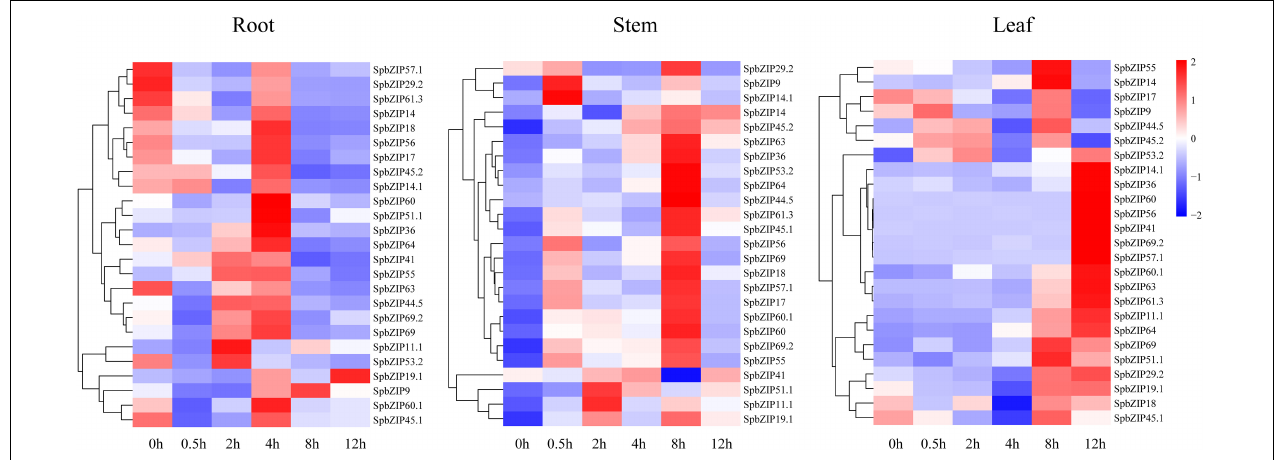
FIGURE 7 | Expression profiles of hub SpbZIP genes in different tissues of S. plumbizincicola soon after the exposure to Cd